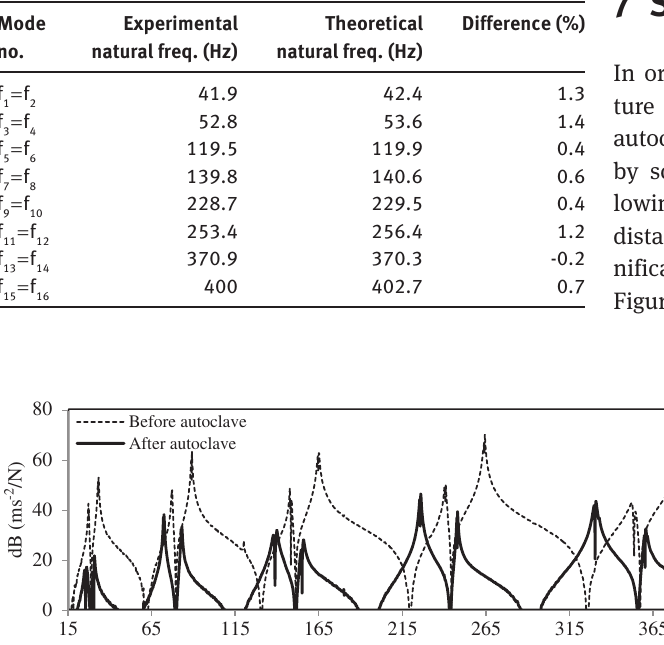
for truncated cone # 21